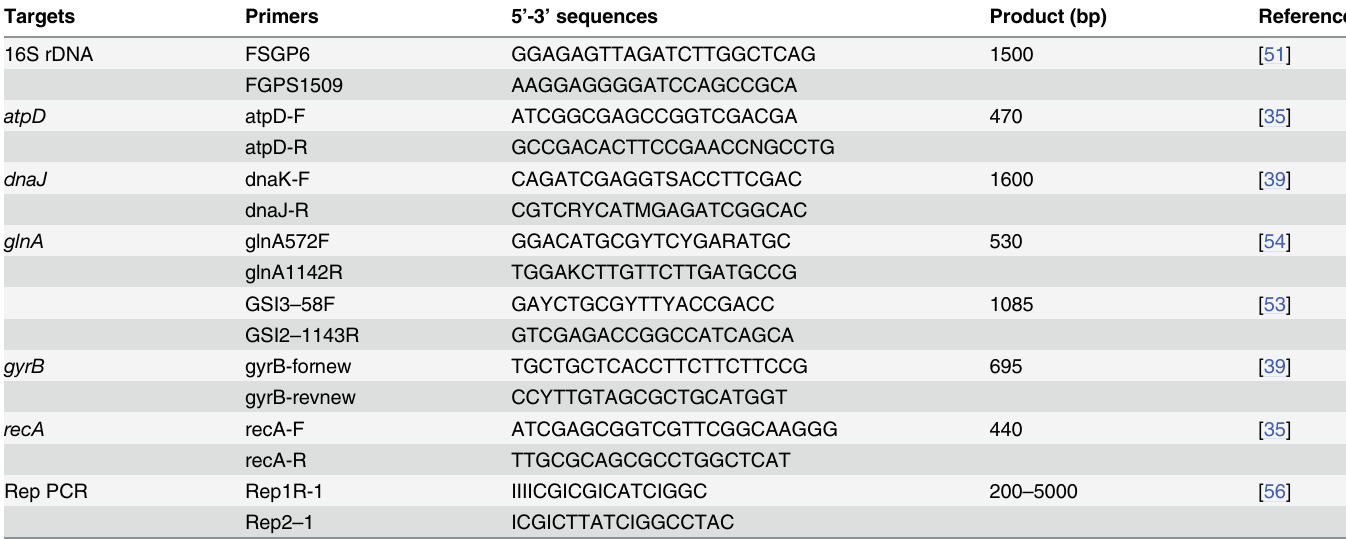
Table 2. Primers used in this study for PCR and Sanger sequencing.